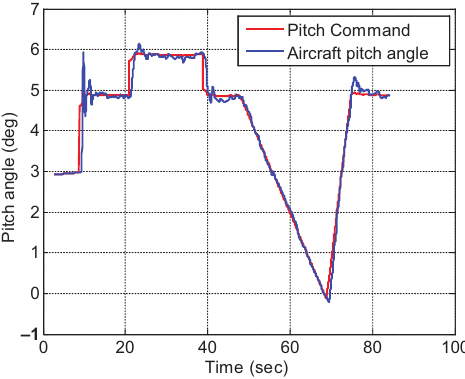
Figure 10. Pilot tracking the Pitch command